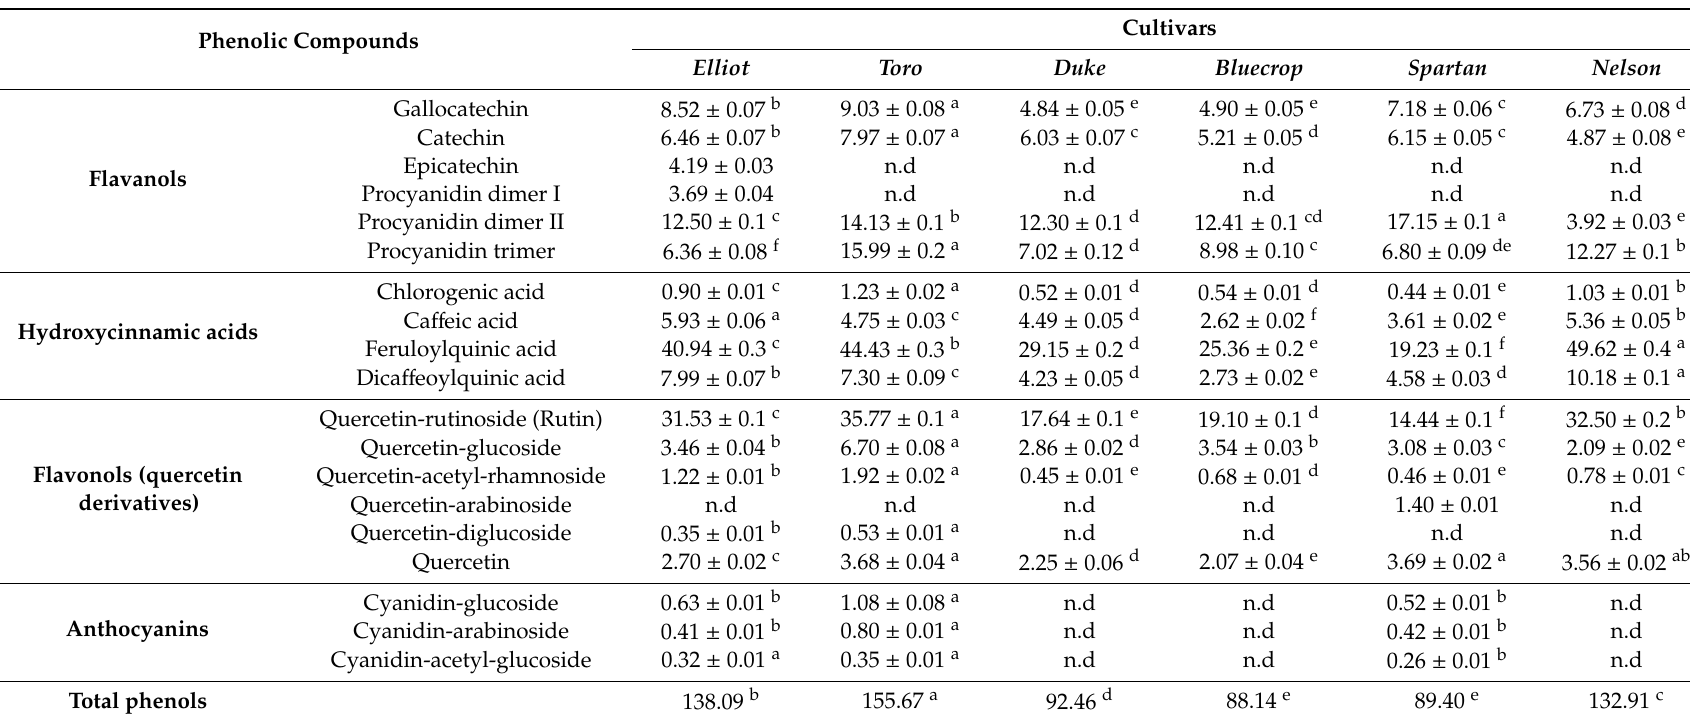
Table 2. The content of individual phenolic compounds in the leaf extracts of the six blueberry varieties, using HPLC-MS and expressed as mg /